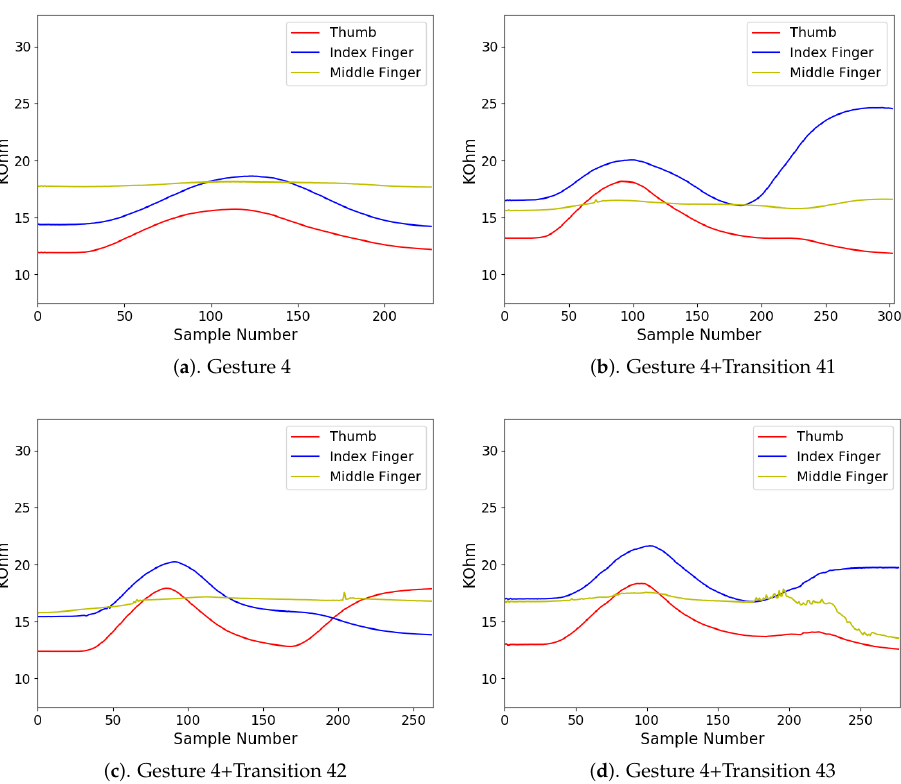
Figure 17. The measured sensory data produced by flex sensors of the smart glove for gesture class 4.